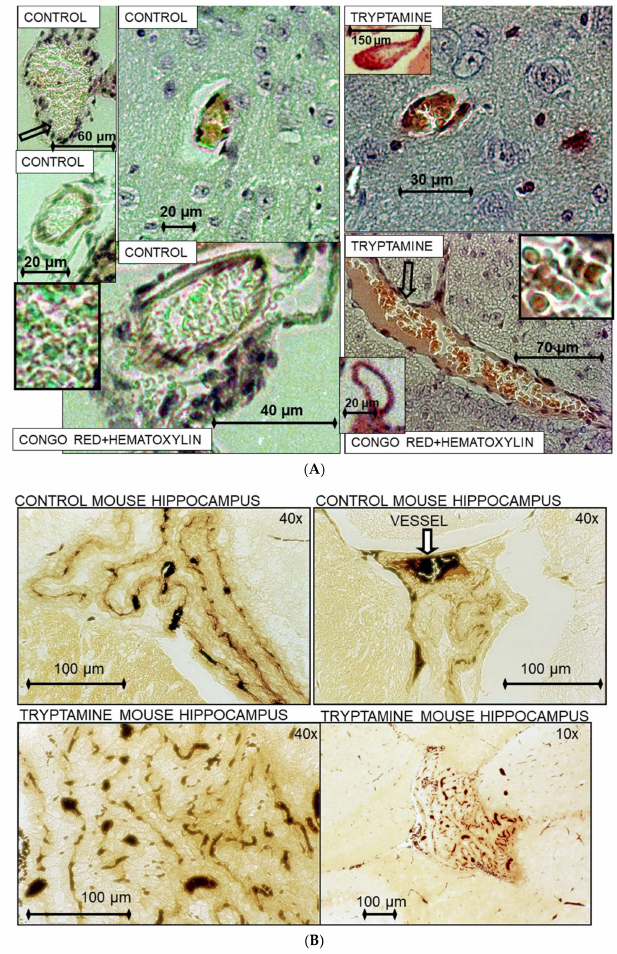
Figure 3. Vasculopathies induced by tryptamine in the hippocampal area of mouse brain. ( A ) The congophilic cerebral angiopathy in blood vessels of tryptamine-treated mouse; ( B ) The Gallyas silver staining shows the evidence of tryptamine-induced